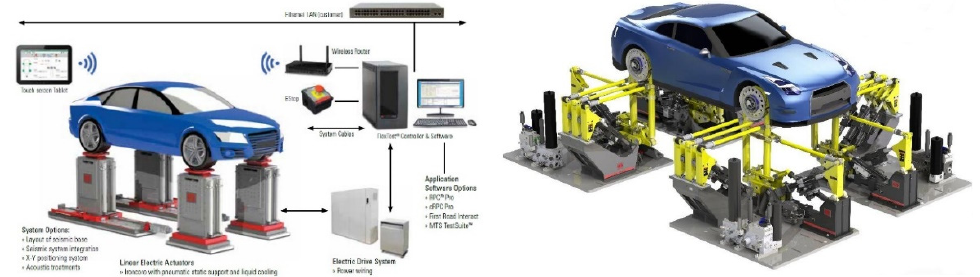
Figure 2. Tire-coupled road simulator ( left ) and spindle-coupled road simulator ( right ) [11].